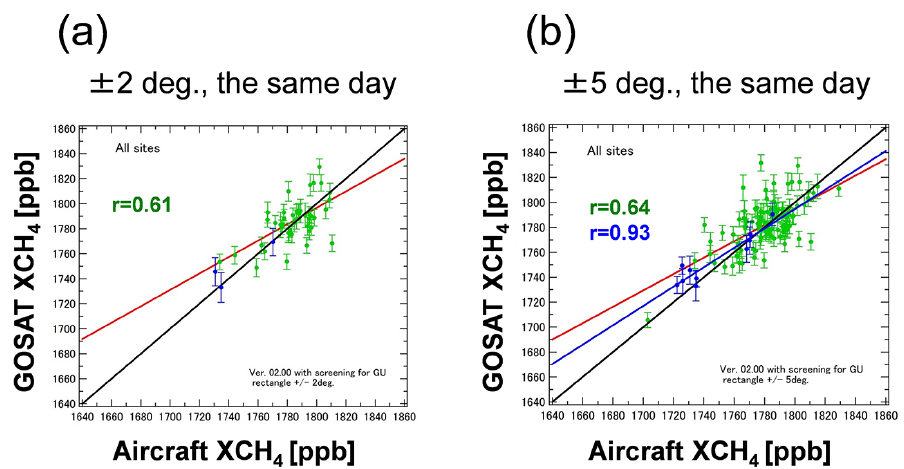
Figure 9. Scatter diagrams between GOSAT XCH 4 observed within (a) ± 2 ◦ and (b) ± 5 ◦ latitude–longitude boxes centered at each aircraft observation site and aircraft-based XCH 4 with the application of CAK measured on a GOSAT overpass day. Green and blue dots indicate GOSAT XCH 4 obtained over land and ocean regions, respectively. Red and blue lines denote the regression lines, statistically significant at the 99% level, over land and ocean regions, respectively. The black lines show one-to-one correspondence.